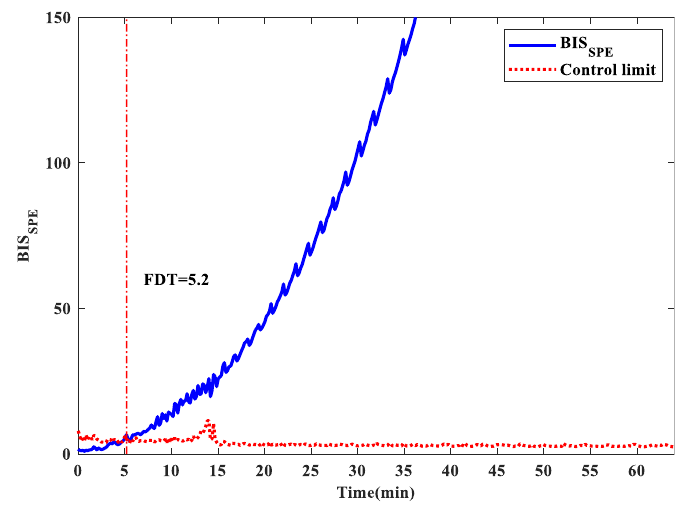
Figure 9. SPE fault monitoring chart of F4 based on NMI-WMPCA.